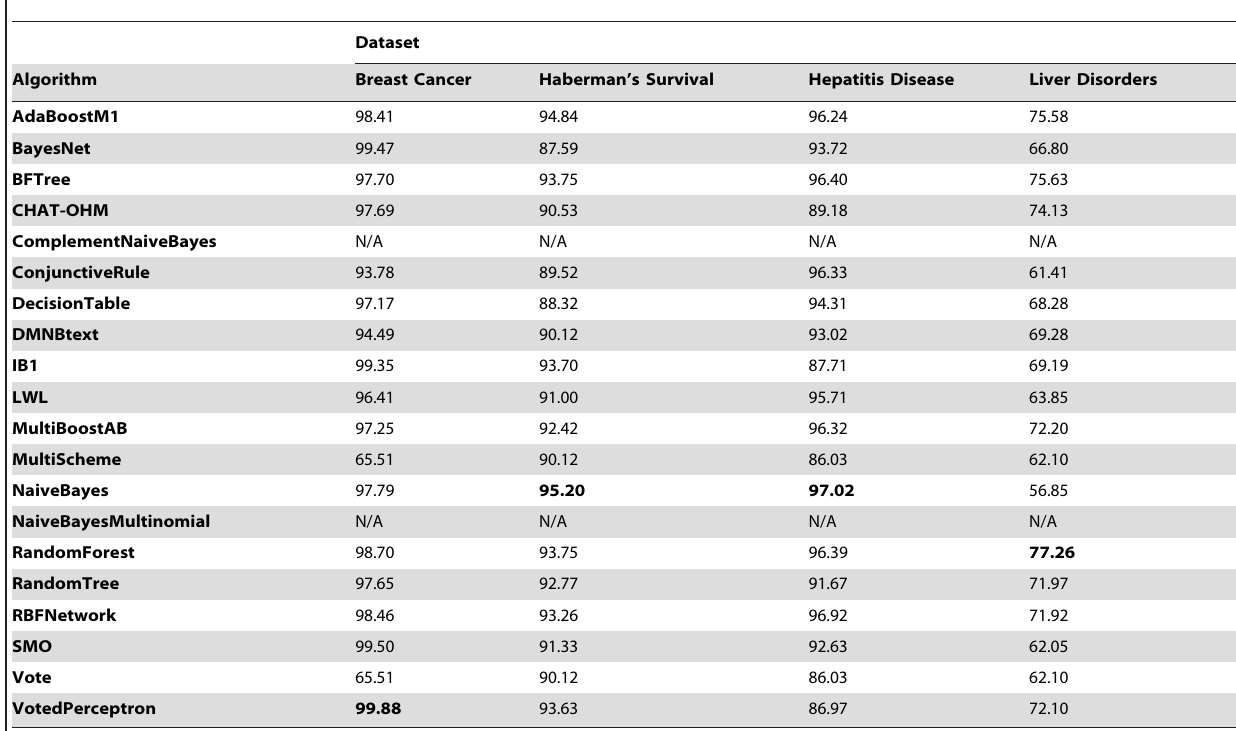
Table 7. Clasification accuracy comparison (%) normalized data without outliers.